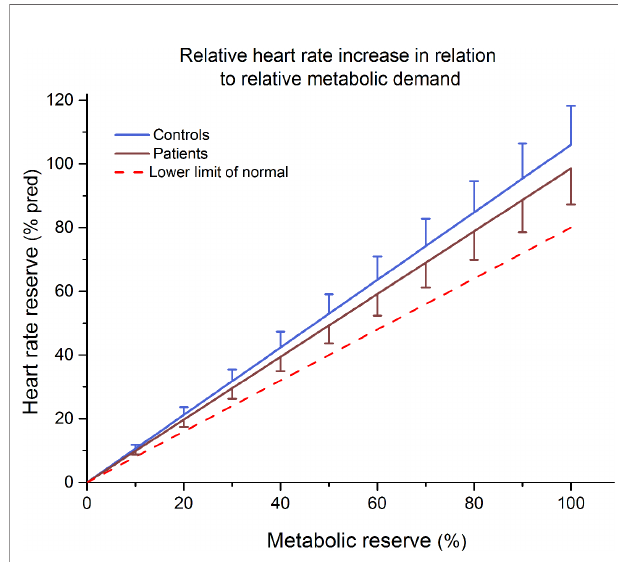
FIGURE 2 | Mean ± 90% con fi dence limit of the increase in percentage heart rate reserve in relation to the increase in percentage metabolic reserve of patients and control subjects. The dotted line represents the lower limit of normal (slope b =